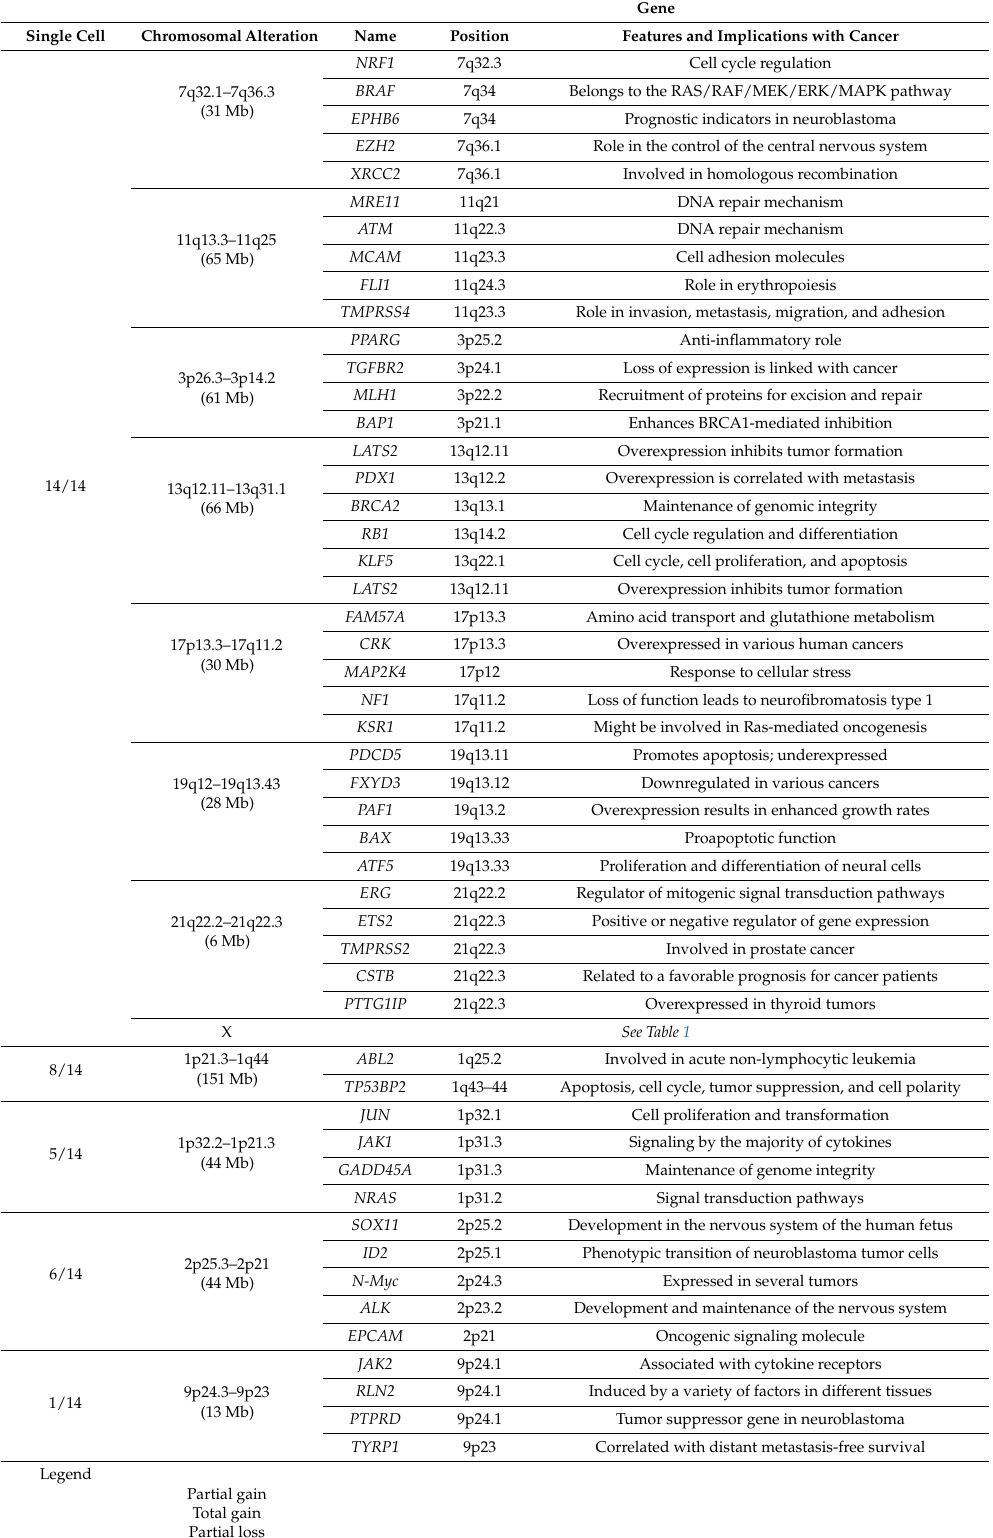
Table 2. The table shows the gain or loss chromosomal regions identified in the 14 SK-N-BE (2)-C single cells analyzed and the main genes implicated in the mechanisms of cancer regulation, according to recent